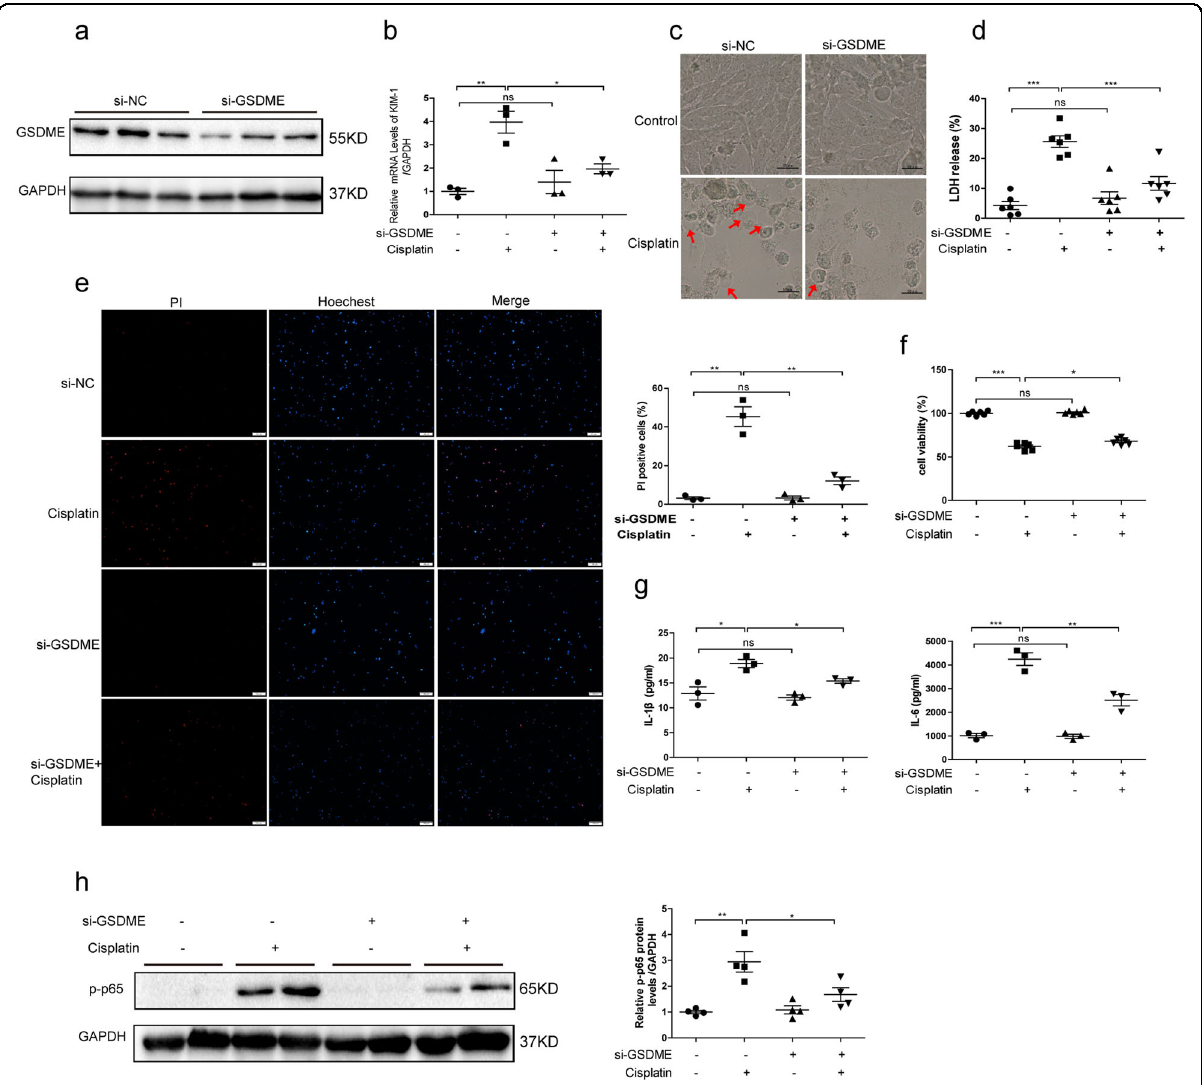
Fig. 6 GSDME knockdown relieved cisplatin-induced cell injury and pyroptosis in human TECs. Human TECs (HK-2) were transfected with FL- GSDME siRNA or the negative control and subsequently treated with cisplatin (10 μ g/mL) for 24 h. a Protein level of FL-GSDME in human TECs after transfection with FL-GSDME siRNA ( n = 3). b Transcriptional levels of KIM-1 ( n = 3). c Representative bright- fi eld microscopic images of cells. Red arrowheads indicate large bubbles from the plasma membrane (scale bar = 50 μ m). d Role of GSDME silencing on LDH release ( n = 6). e PI staining of cells with GSDME knockdown (scale bar = 100 μ m; n = 3). f Role of GSDME siRNA on cell viability ( n = 6). g IL-1 β and IL-6 release in cells ( n =